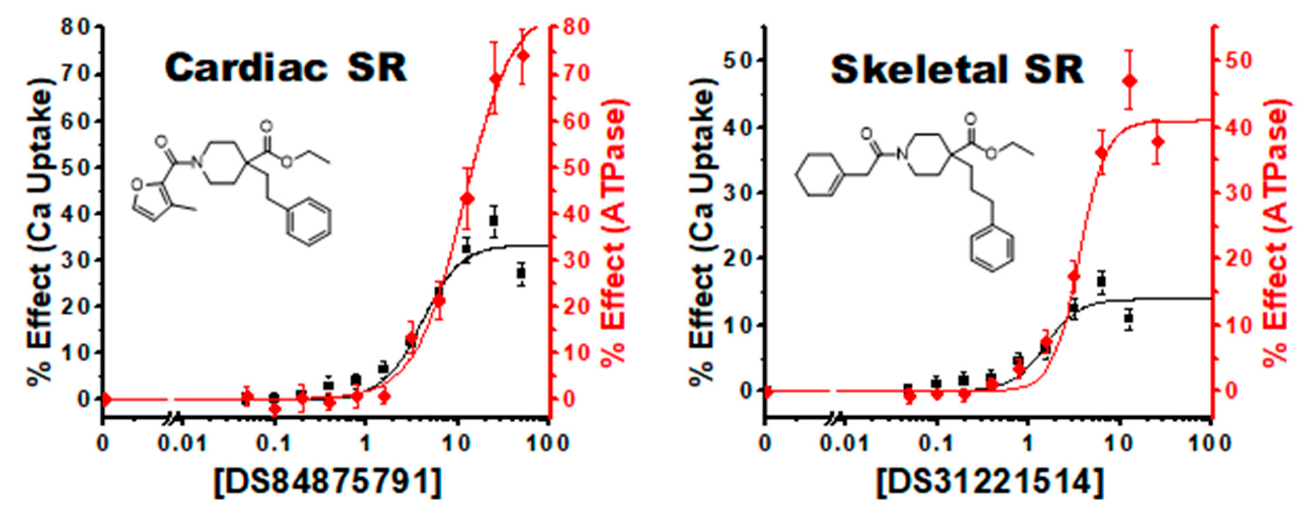
Figure 4. Linked Activating Compounds: Concentration response curves of compounds #9 (DS84875791) in cardiac SR and #7 (DS31221514) display a comparable change at lower compound concentrations, although ATPase achieves a greater maximal effect at the highest compound concentrations. n = 3, ± SEM.